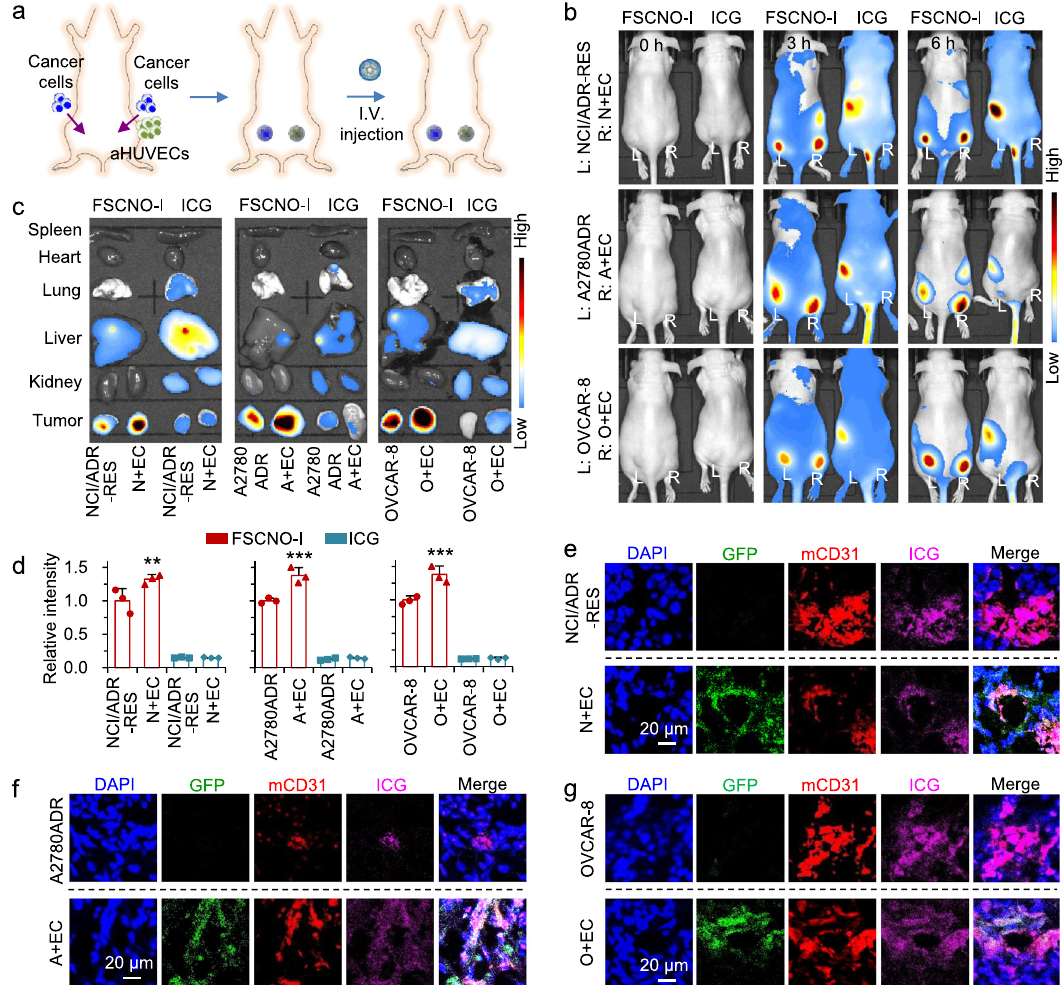
Fig. 6 Tumor-targeting capability of FSCNO-DH nanoparticles. a Schematic illustration of establishing tumors in mice by implanting NCI/ADR-RES, A2780ADR, or OVCAR-8 cells at the left dorsal side of the upper hindlimb of mice and the three types of cancer cells co-injected with aHUVECs at the right side of the same mice. b In vivo whole animal imaging of indocyanine green (ICG) fl uorescence before and at different time points after intravenous (i.v.) injection via the tail vein in the form of free ICG and ICG-laden FSCNO (FSCNO-I) nanoparticles. Tumors on the left side (L) were formed with NCI/ ADR-RES, A2780ADR or OVCAR-8 cells and tumors on the right side (R) were formed with co-injection of the respective cancer cells and aHUVECs (N + EC, A + EC, or O + EC). c Ex vivo imaging of ICG fl uorescence in the tumors and critical normal organs collected from mice injected with